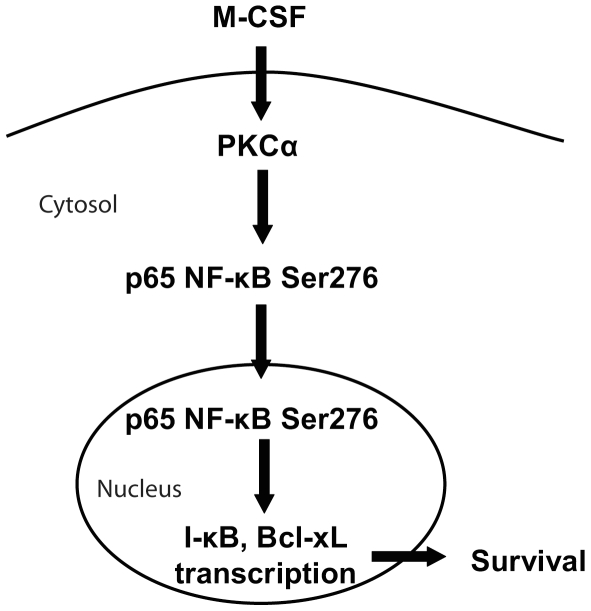
Proposed model for M-CSF-induced monocyte survival via PKC regulation by activating NF-κB p65 phosphorylation at Ser276.